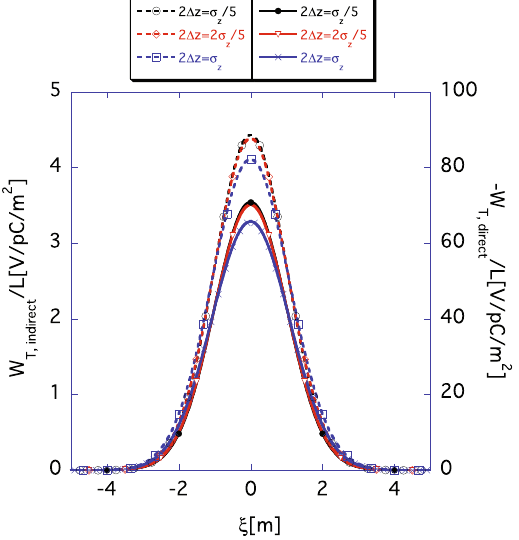
Figure 9. Mesh size 2 Δ z dependence of indirect wake functions W T , indirect ( ξ ) according to Eq. (74) and of direct wake function W T , direct ( ξ ) according to Eq. (75) for a beam with β = 0.1 and σ z = 1 m, where r b = 10 mm and a = 40 mm. The dashed (read using the scale markings on the left axis) and the solid (read using the scale markings on the right axis) lines show the indirect W T , indirect ( ξ ) and the direct W T , direct ( ξ ) space-charge wake functions. The black, red and purple lines show the wake functions for 2 Δ z = σ z /5, for 2 Δ z = 2 σ z /5, and for 2 Δ z = σ z ,